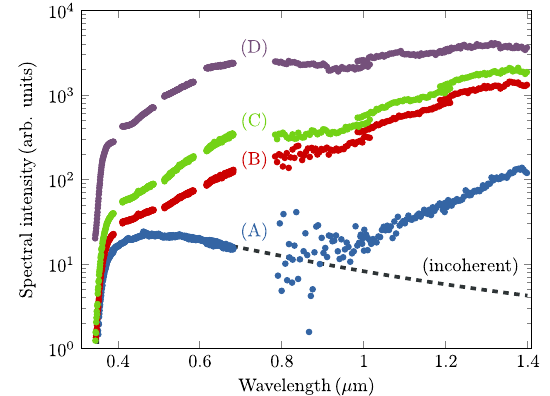
FIG. 6. Spectral intensity measurements of transition radiation in the visible and near-infrared wavelength range for four different compression settings: (A) FEL operation and (B)–(D) marginal compression, i.e., on-crest rf operation with in the bunch compressors (see Ref. [16] for decreasing R 56 experimental details). The spectral intensity of the incoherent part of transition radiation is indicated as dashed black